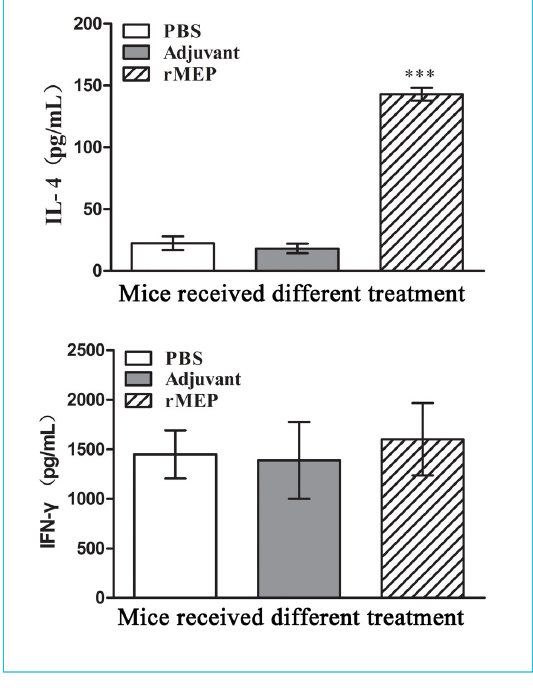
Figure 6: Cytokine secretion of the splenocytes from mice that received different treatments (n = 6). Splenocytes were iso- lated from six mice in each group at day 21 after the third immuni- sation and cultivated with the stimulation of rMEP. IL-4 and IFN-γ secretion in the cell culture supernatants were measured. Data are shown as the mean ± SD. *** P<0.001 compared with the PBS or adjuvant treated group.